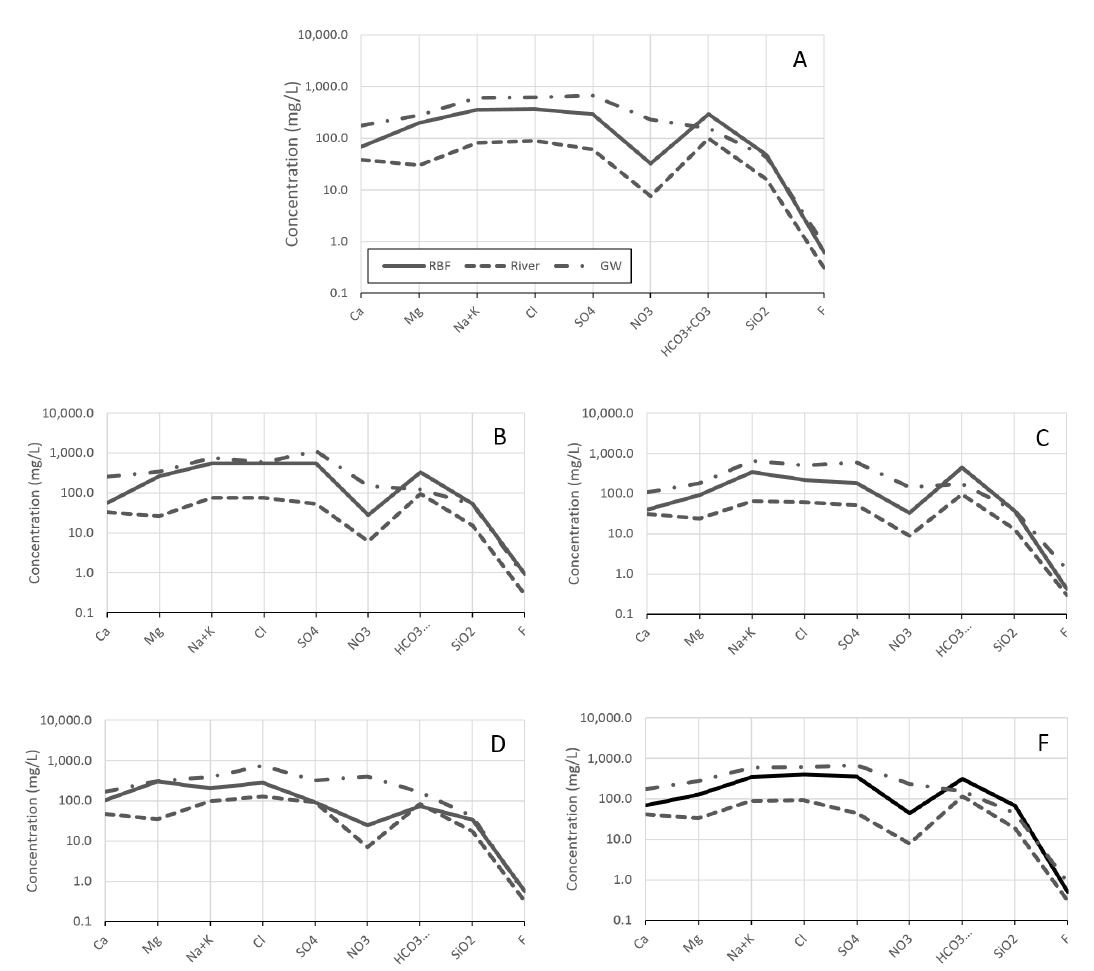
Figure 3. Major ion concentrations (mg/L) in the RBF wells (RBF, n = 52), the Krishna River (River, n = 43), and the shallow groundwater (GW, n = 10). ( A ) Averages across all villages, ( B ) Village 1, ( C ) Village 2, ( D ) Village 3, and( E ) Village 4 RBF 2. No GW was analyzed in Village 3; the average GW composition was graphed instead.